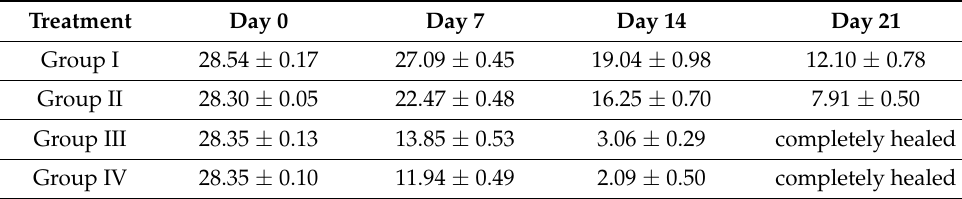
Table 2. Wound area (cm 2 ) in the different treatment groups of